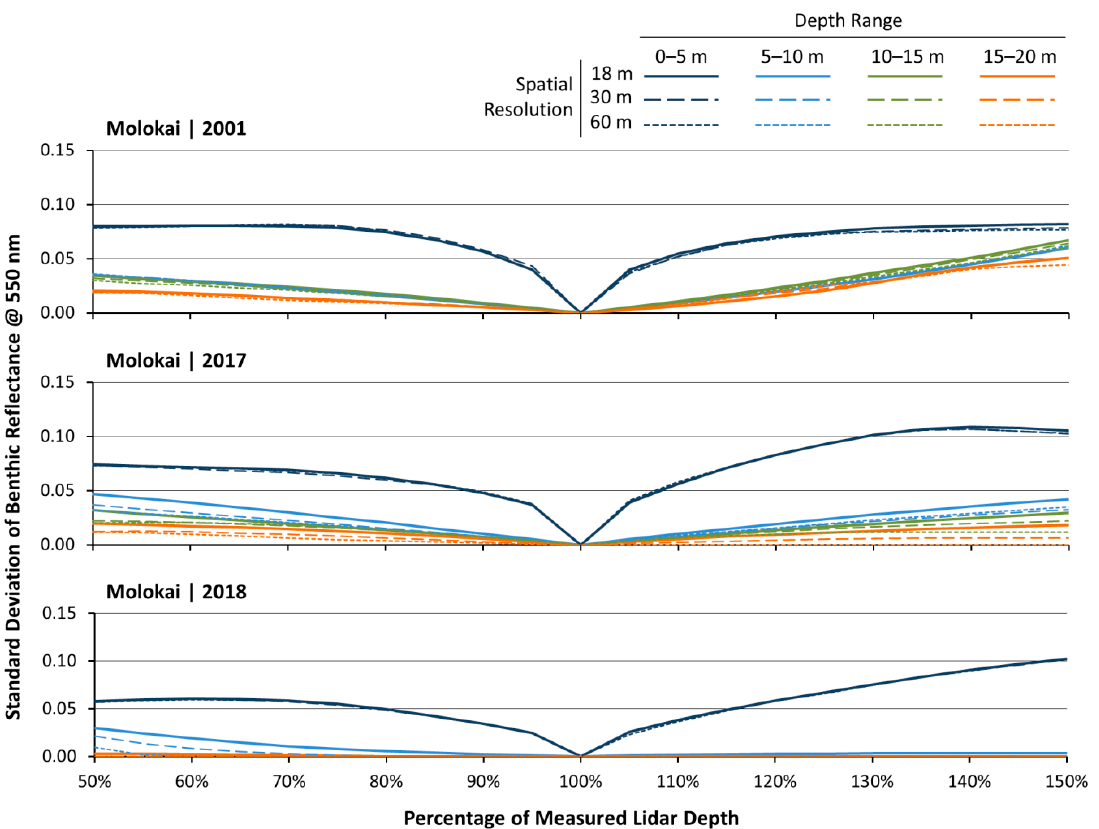
Figure 10. Sensitivity analysis of derived benthic reflectance at 550 nm for Molokai AVIRIS-C data at 18, 30, and 60 m spatial resolution; illustrating differences in standard deviation of derived reflectance as a function of variations in water depth.